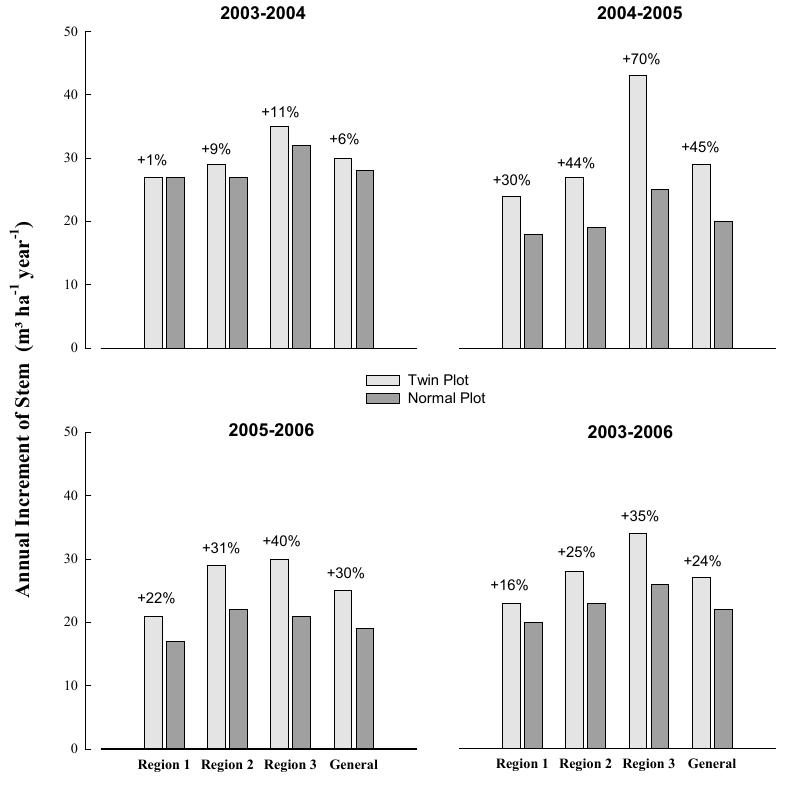
Figure 2. Correlation between initial volume of twin (TP) and normal (NP) plots.